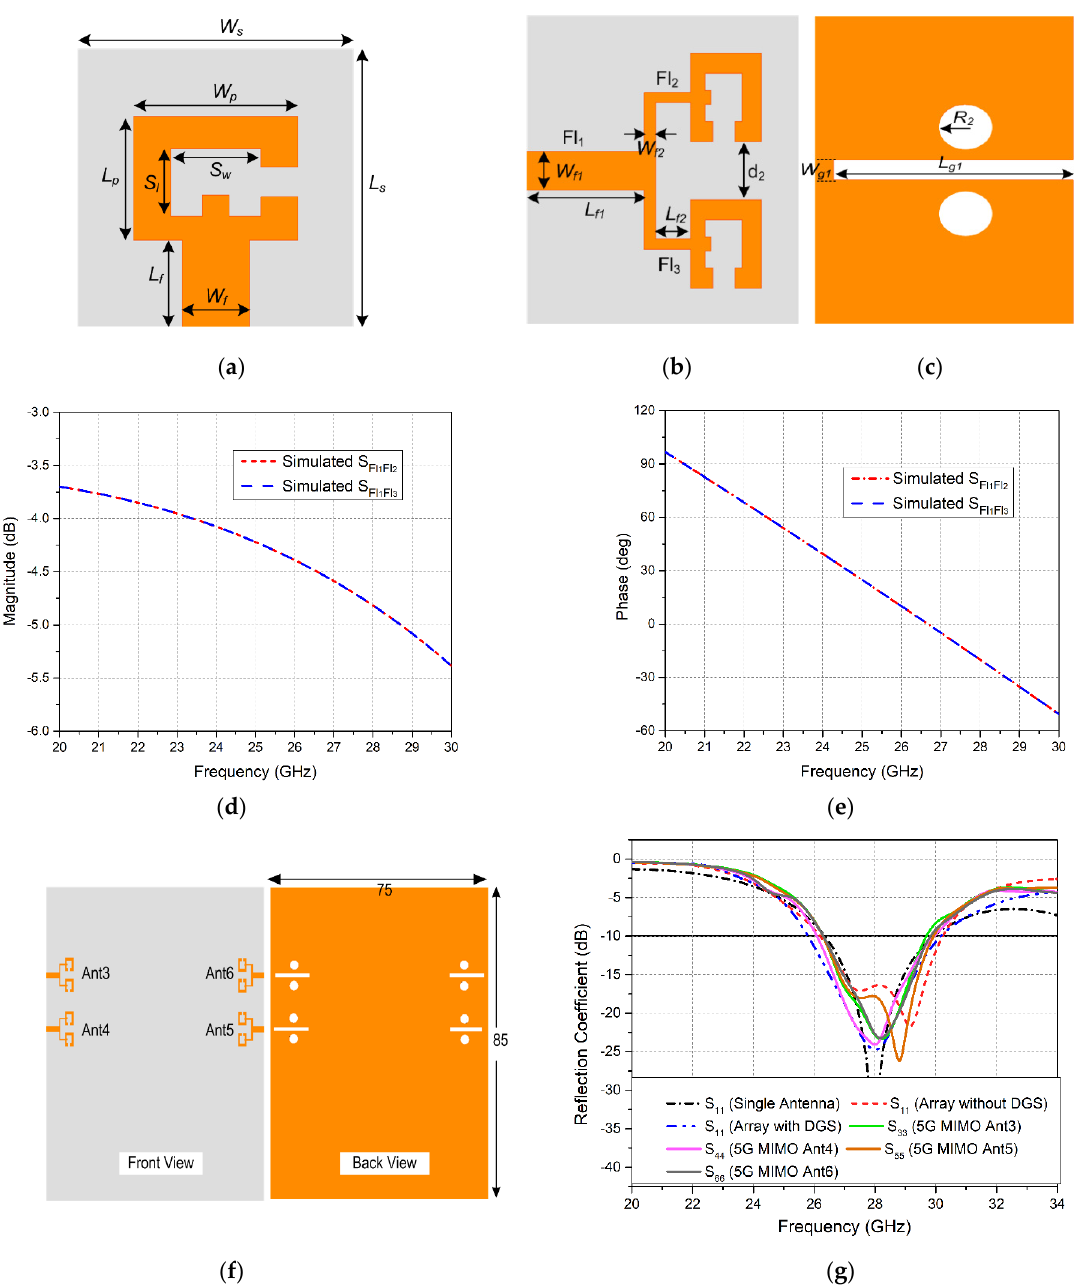
Figure 4. Geometry of 5G antennas: ( a ) Single Patch Antenna; ( b ) 5G Antenna Array, Front View; ( c ) 5G Antenna Array, Back View; ( d ) Simulated Transmission coefficient magnitude curves of the feed network; ( e ) Simulated Transmission coefficient phase curves of the feed network; ( f ) 5G MIMO Design; ( g ) Simulated Reflection Coefficient Curves for 5G Antenna.